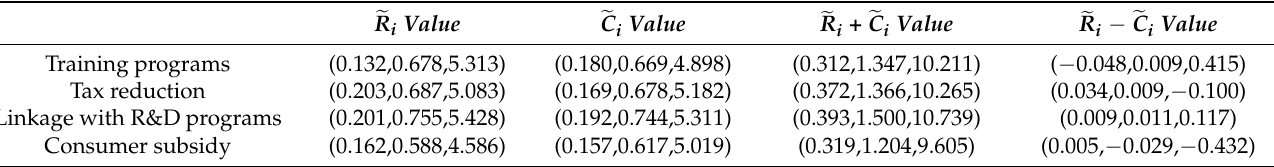
 R value ,  C value ,  i i